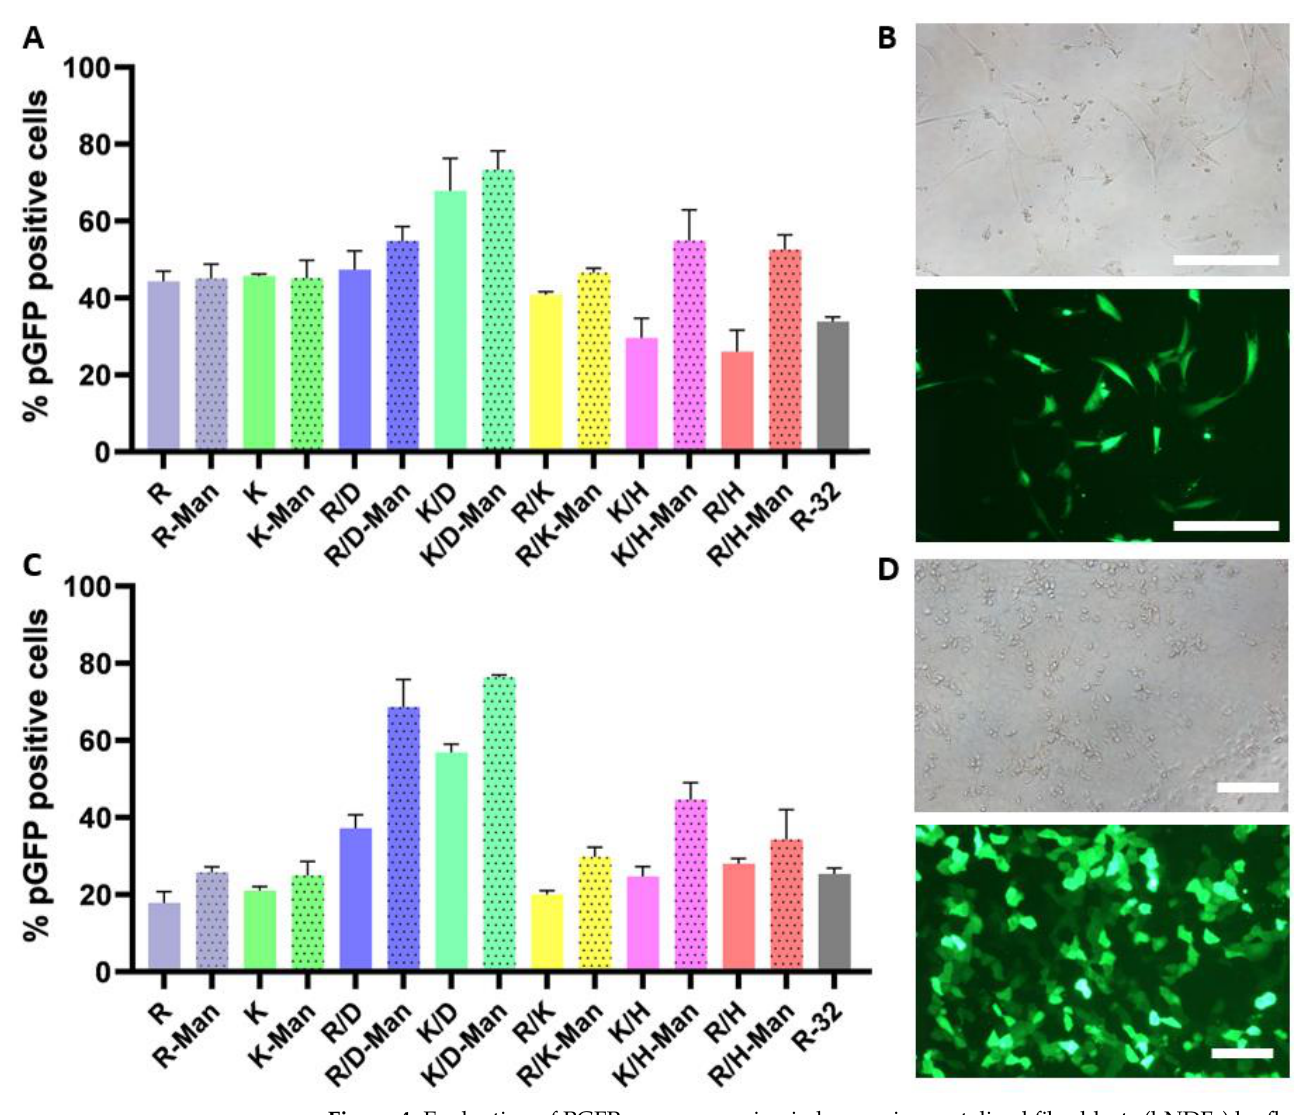
Figure 4. Evaluation of PGFP gene expression in human immortalized fibroblasts (hNDFs) by flow cytometry ( A ) and microscopy ( B ). Scale bar = 100 µm. Quantification of GFP-positive cells following transfection of HaCaT cells with OM- and MM-derived polyplexes by flow cytometry ( C ). Light and fluorescence microscopy of immortalized keratinocytes ( D ). Scale bar = 50 µm. All cell lines were transfected with the OM- and MM-PBAE libraries by adding 0.3 µg pDNA/well at a 50:1 polymer-to-pDNA weight ratio. Arginine-terminated 32 PBAE was used as positive control. Images depict cells transfected with K/D-Man-derived polyplexes. Results are presented as mean and standard deviation of triplicates (mean ± SD).